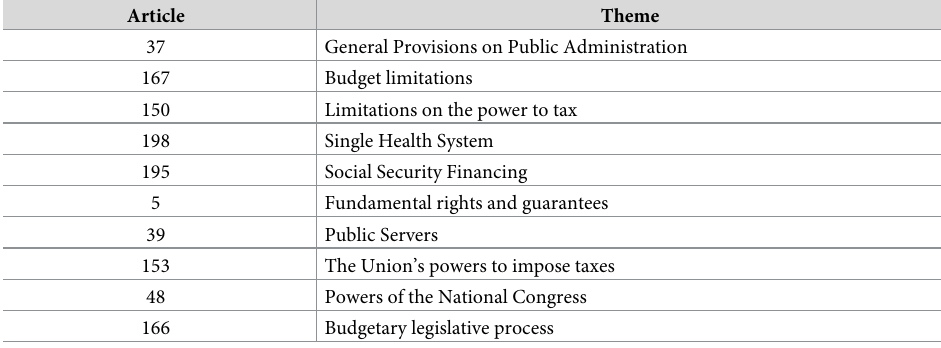
Table 2. Articles with the highest number of connections in the